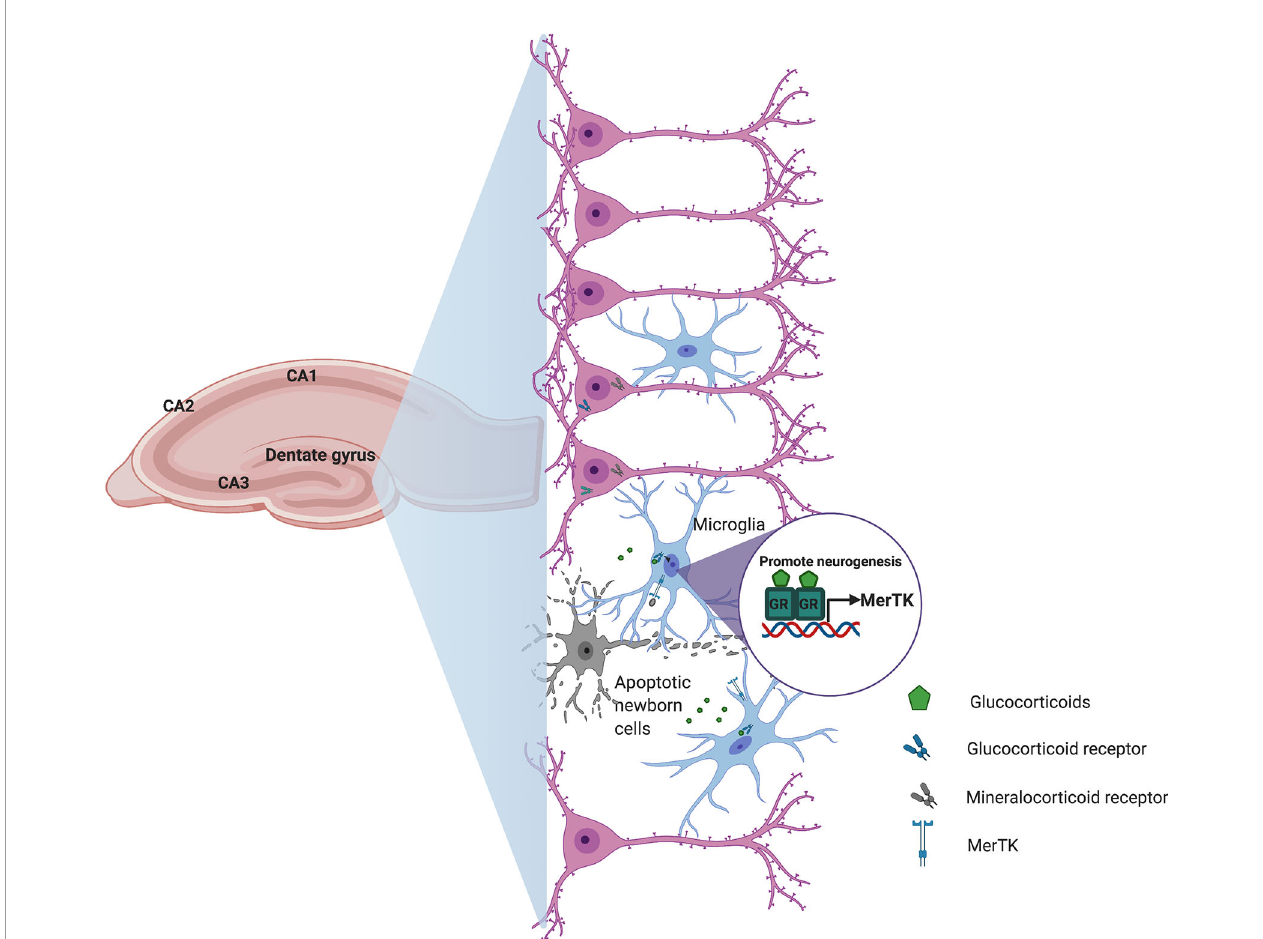
FIGURE 2 | Schematic representation of how glucocorticoids could contribute to central nervous system homeostasis. During hippocampal neurogenesis, cell debris derived from apoptotic newborn cells and stress-induced glucocorticoid secretion promote microglia activation and transcriptional induction of the phagocytic receptor Mertk to regulate the production of new neurons in order to maintain homeostasis in the adult hippocampal neurogenic